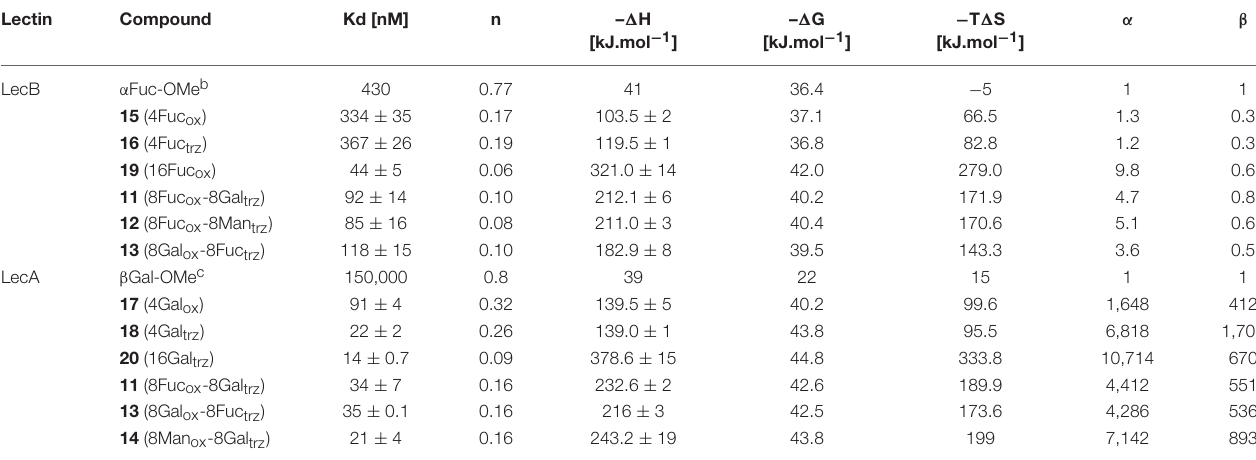
TABLE 1 | Isothermal titration microcalorimetry data for binding to LecA and LecB a .